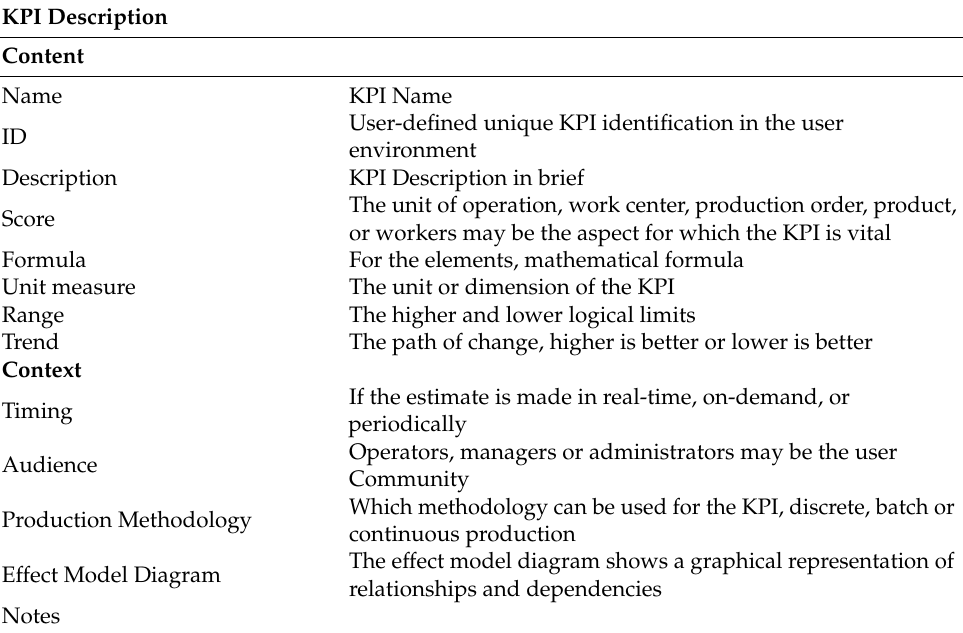
Table 2. ISO 22400 KPI description table.